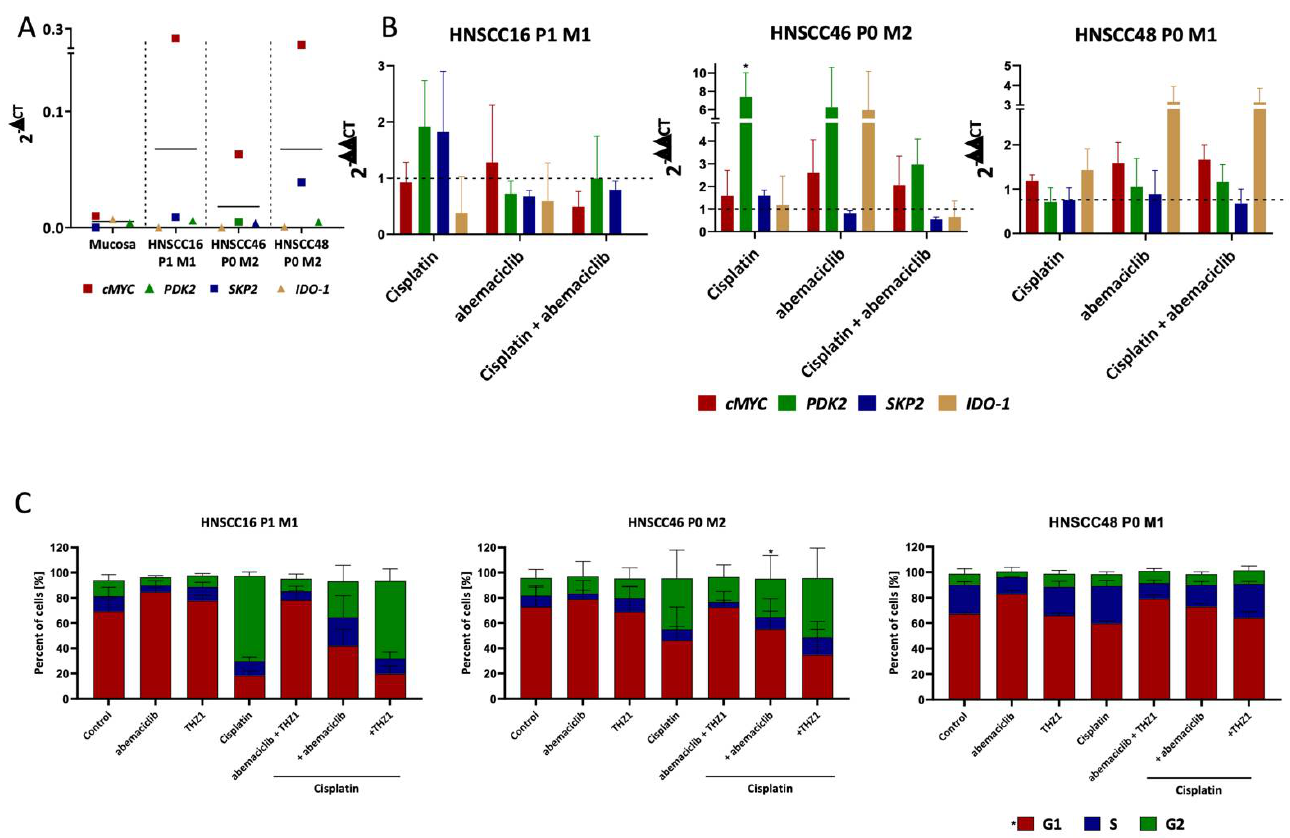
Figure 6. Expression of resistance-associated genes (SKP2, cMYC, PDK2, and IDO-1) and cell cycle analysis ( A ) Quantitative real-time PCR was carried out on untreated HNSCC cell lines and compared to benign mucosa ( B ) Influence of 2 × 72 h treatment on the expression of the resistance-associated genes cMYC, PDK2, SKP2, and IDO-1 . Drug doses were abemaciclib [HNSCC16 P1 M1/HNSCC46 P0 M2: 1 µM, HNSCC48 P0 M1: 0.1 µM], and Cisplatin [HNSCC16 P1 M1/HNSCC46